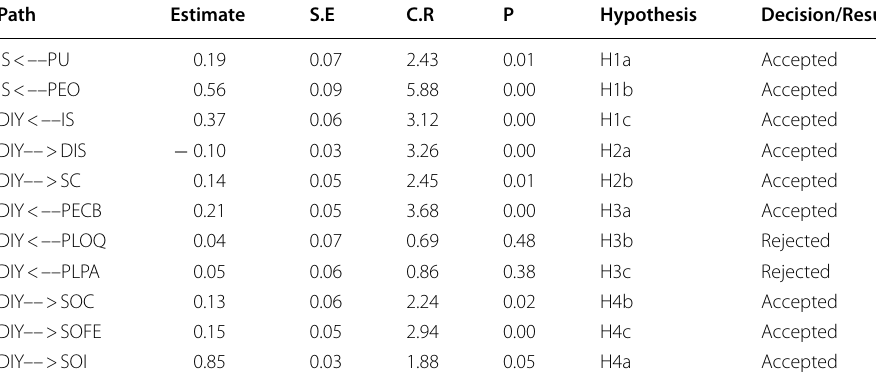
Table 4 Summary of hypotheses